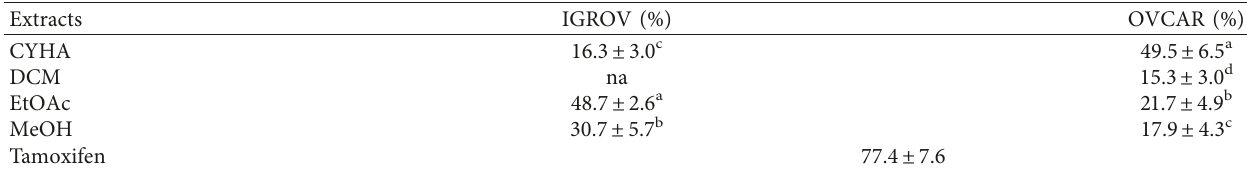
Table 7: Cytotoxic activity of M. mabokeensis Aubr´ev bark extracts (50 μ g/mL) against IGROV and OVCAR cell lines. Extracts CYHA